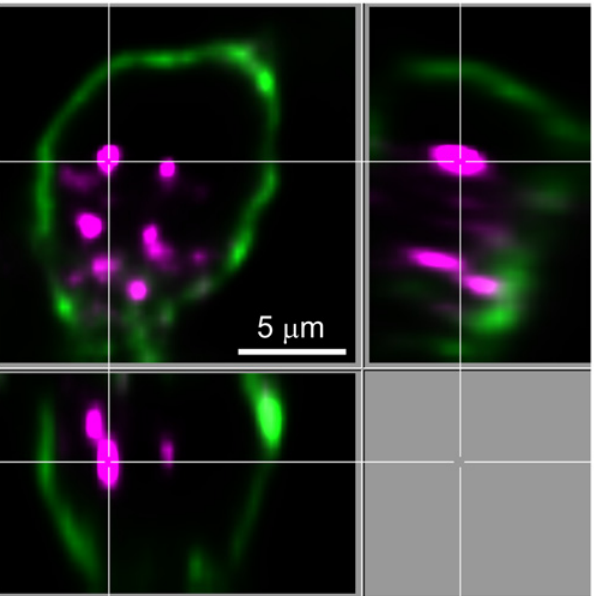
Fig 4. Neuronal cell body-associated 263K A647 particles are intracellular. To provide formal proof of the intracellular localization of 263K A647 particles (magenta) in cell bodies, neuronal cultures at 4 dpe were cooled to 4°C to inhibit endocytosis and treated with Alexa Fluor 488-tagged wheat germ agglutinin (green) to specifically label the cell surface. After labeling the cells were rinsed, fixed, and imaged by confocal microscopy. An orthogonal projection of a single optical slice from near the middle of the cell in a merged image is shown.